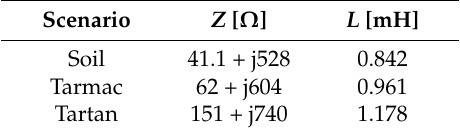
Table 1. Measured values of Impedance and Inductance for different